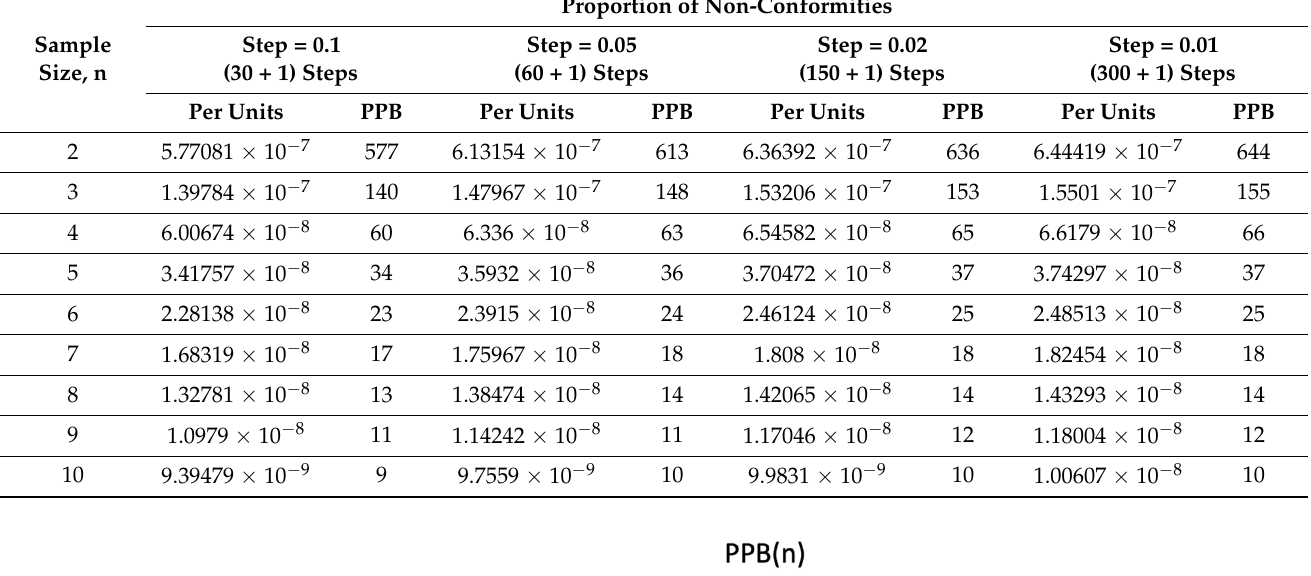
Table 1. The values for parts per billion, for n = 2 . . . 10, obtained for different work steps.